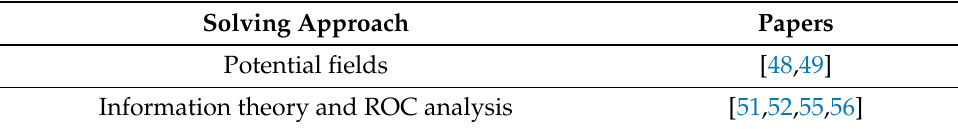
Table 2. Approaches to solve coverage/search games and papers which use